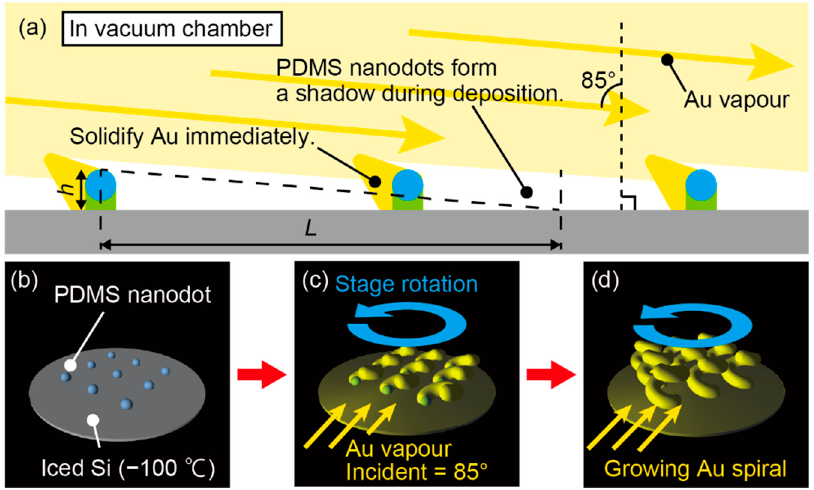
Figure 2. Overview of fabrication of Au nanospiral structures with cryogenic glancing angle deposition. ( a ) The PDMS nanodot templates are irradiated with Au vapor from 85 ◦ , the dots shadow each other, and Au is deposited at the tips of the dots. ( b – d ) Since the substrate is at an extremely low temperature, the Au solidifies instantaneously, and when the stage is rotated, a three-dimensional helical structure is formed.